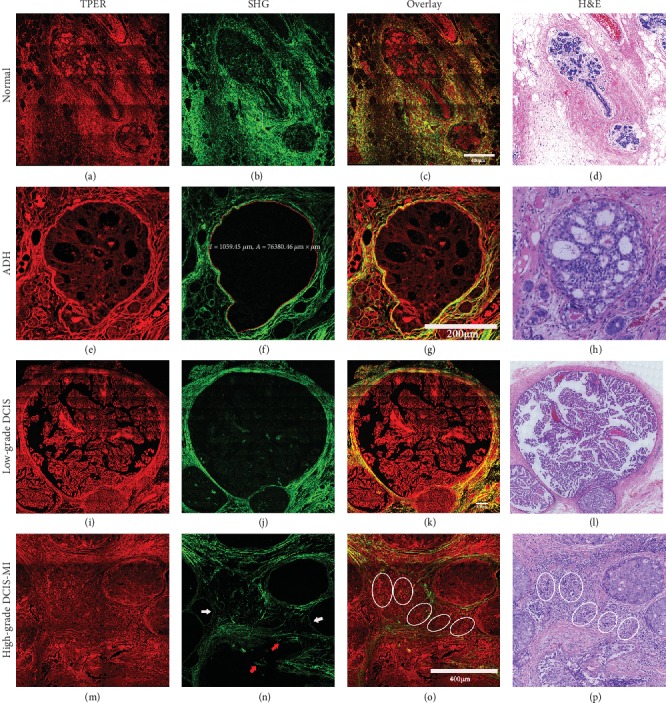
Representative MPM images and corresponding H&E images of normal breast tissue, ADH, low-grade DCIS, and high-grade DCIS-MI. White arrow: complete basement membrane; red arrow: broken basement membrane; white oval: microinvasion cancer cells.